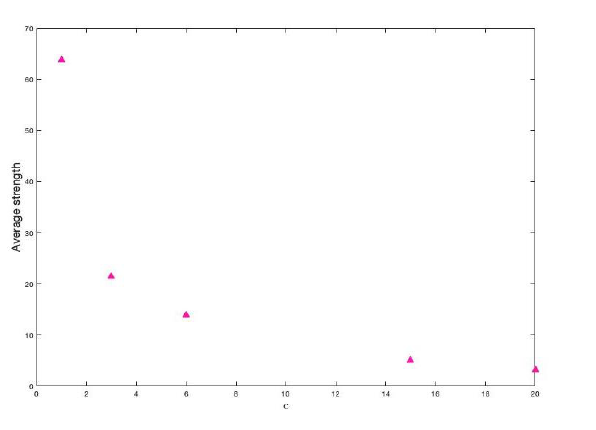
Figure 15. Average strength of vertices for each value of c